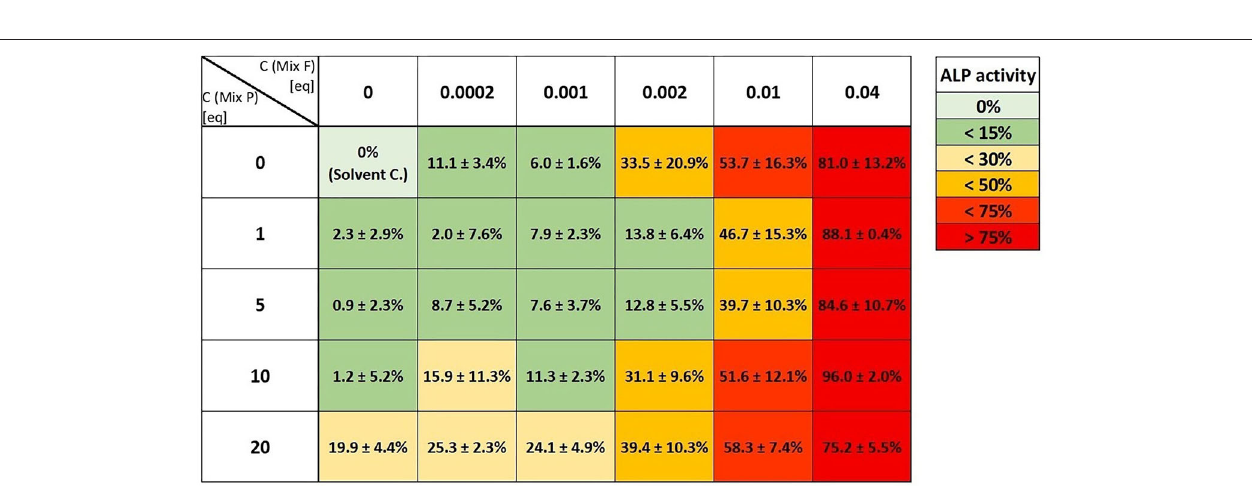
FIGURE 7 | Combination Index (CI) analysis of total mixture estrogenicity. Graph (A) depicts the isobologram indicating a slight synergism at ED 50 levels. The effect-CI plot in graph (B) depicts the course of interactive strength in dependence of effect strength.